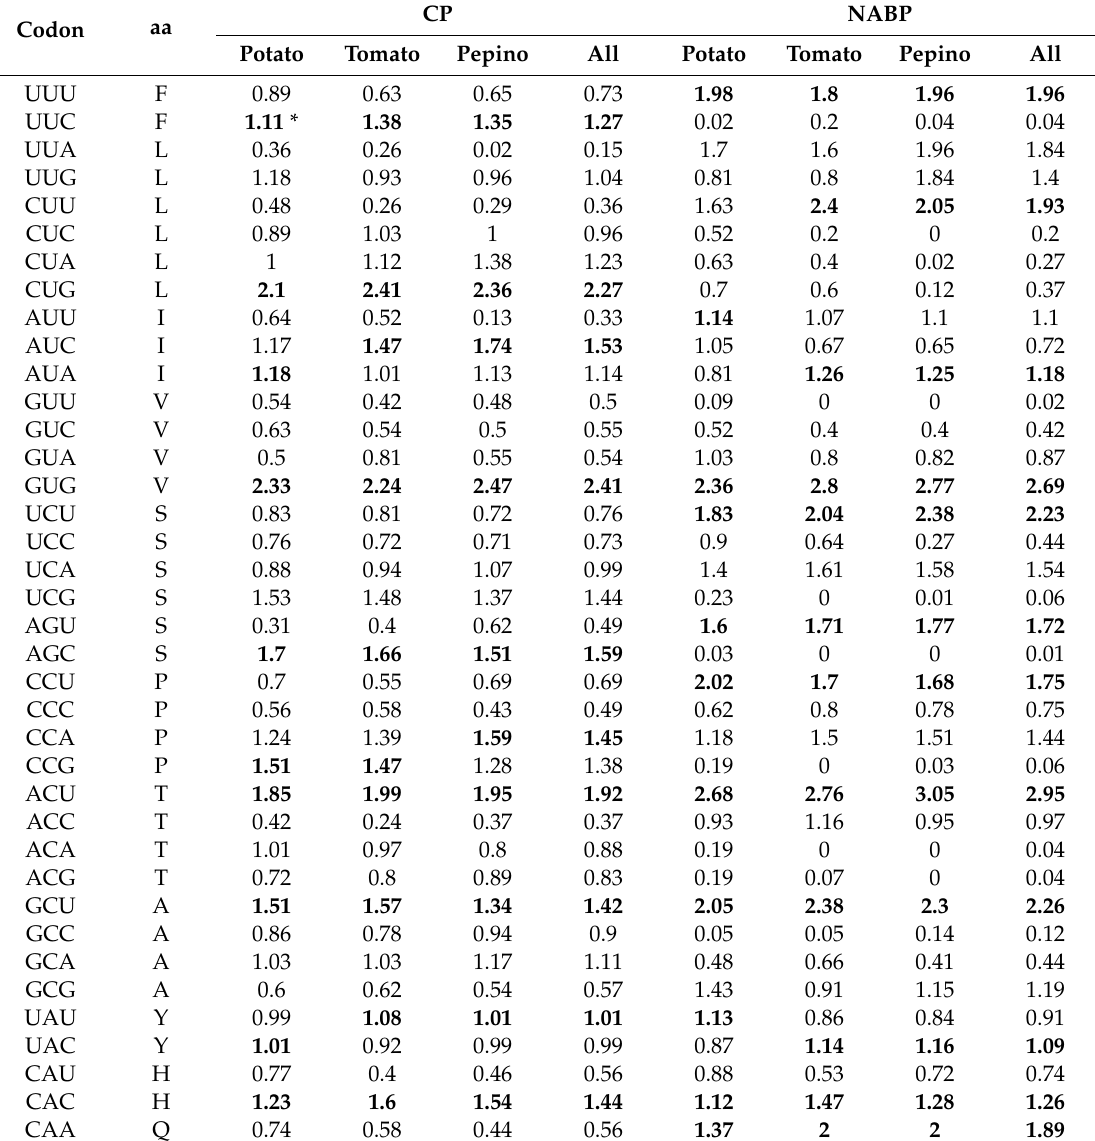
Table 1. The relative synonymous codon usage (RSCU) value of 59 codons encoding 18 amino acids according to hosts of potato virus M coat protein (PVM CP) and cysteine-rich nucleic acid binding protein (NABP)